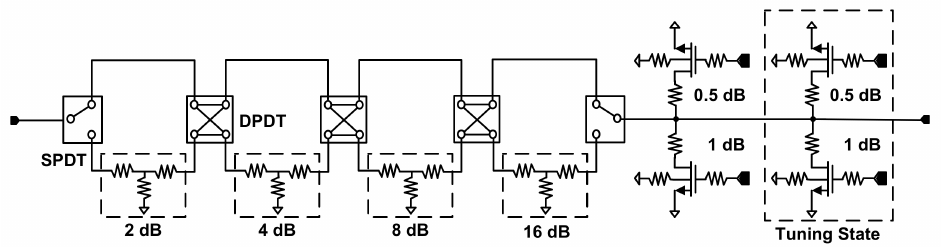
Figure 6. Block diagram of the Ku-band 6-bit digital step attenuator.